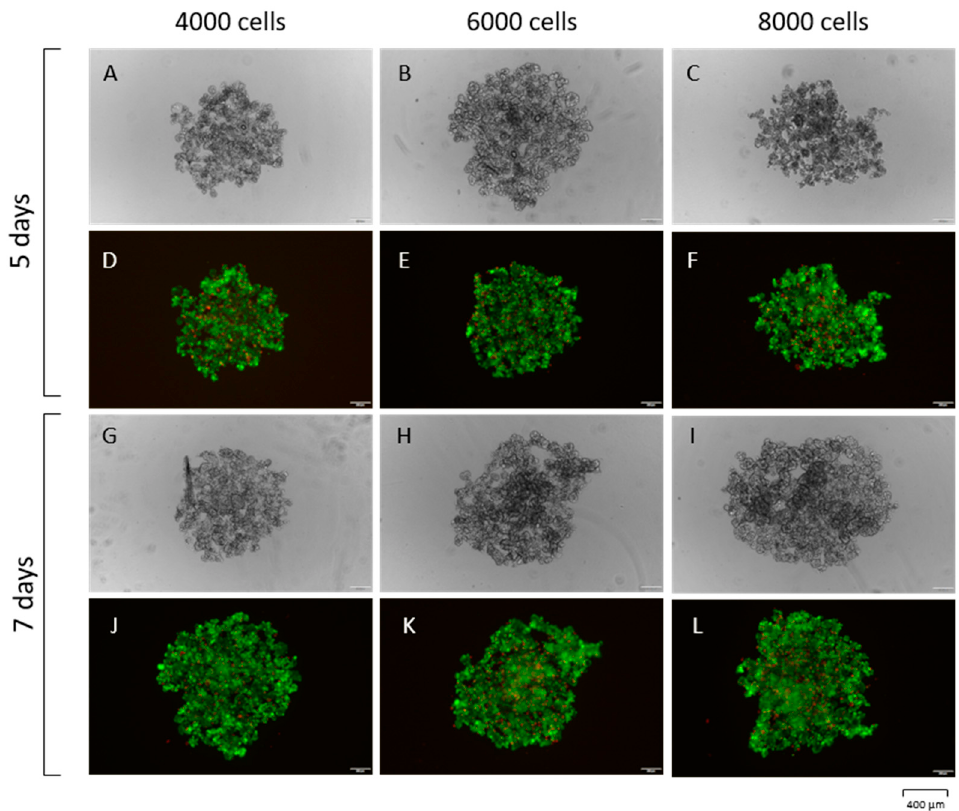
Figure 2. Live/dead assay of the MCF-7 3D model. BC spheres were observed after 5 days of forming in a bright field containing 4000 cells ( A ), 6000 cells ( B ), and 8000 cells ( C ). The identical spheres were tested with the live/dead assay ( D – F ). After 7 days of formation, identical BC spheres were photographed using the bright field ( G – I ) and live/dead assay ( J – L ). The FITC channel was used to present the green alive cells, and the Texas Red channel for the red, dead ones.